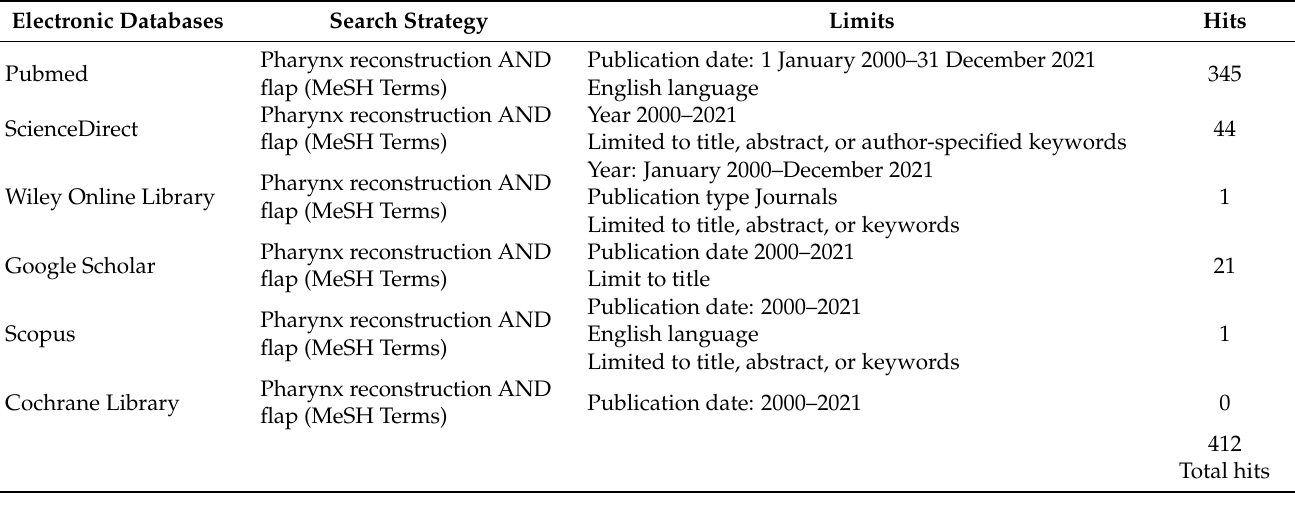
Table 1. Search strategy used for each database with the corresponding